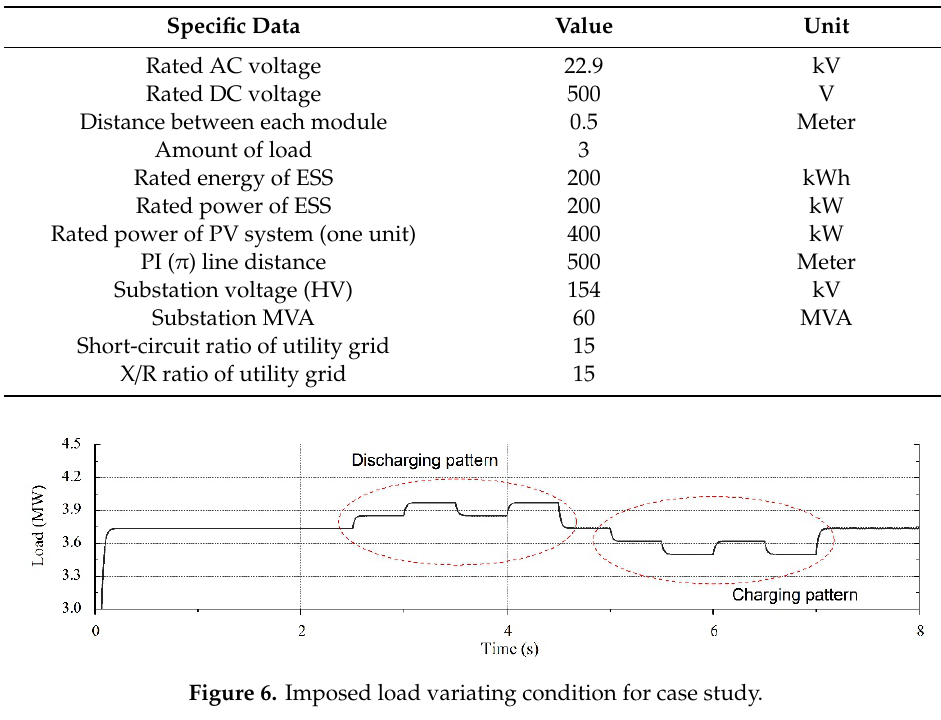
Table 2. Numerical data for the simulation.